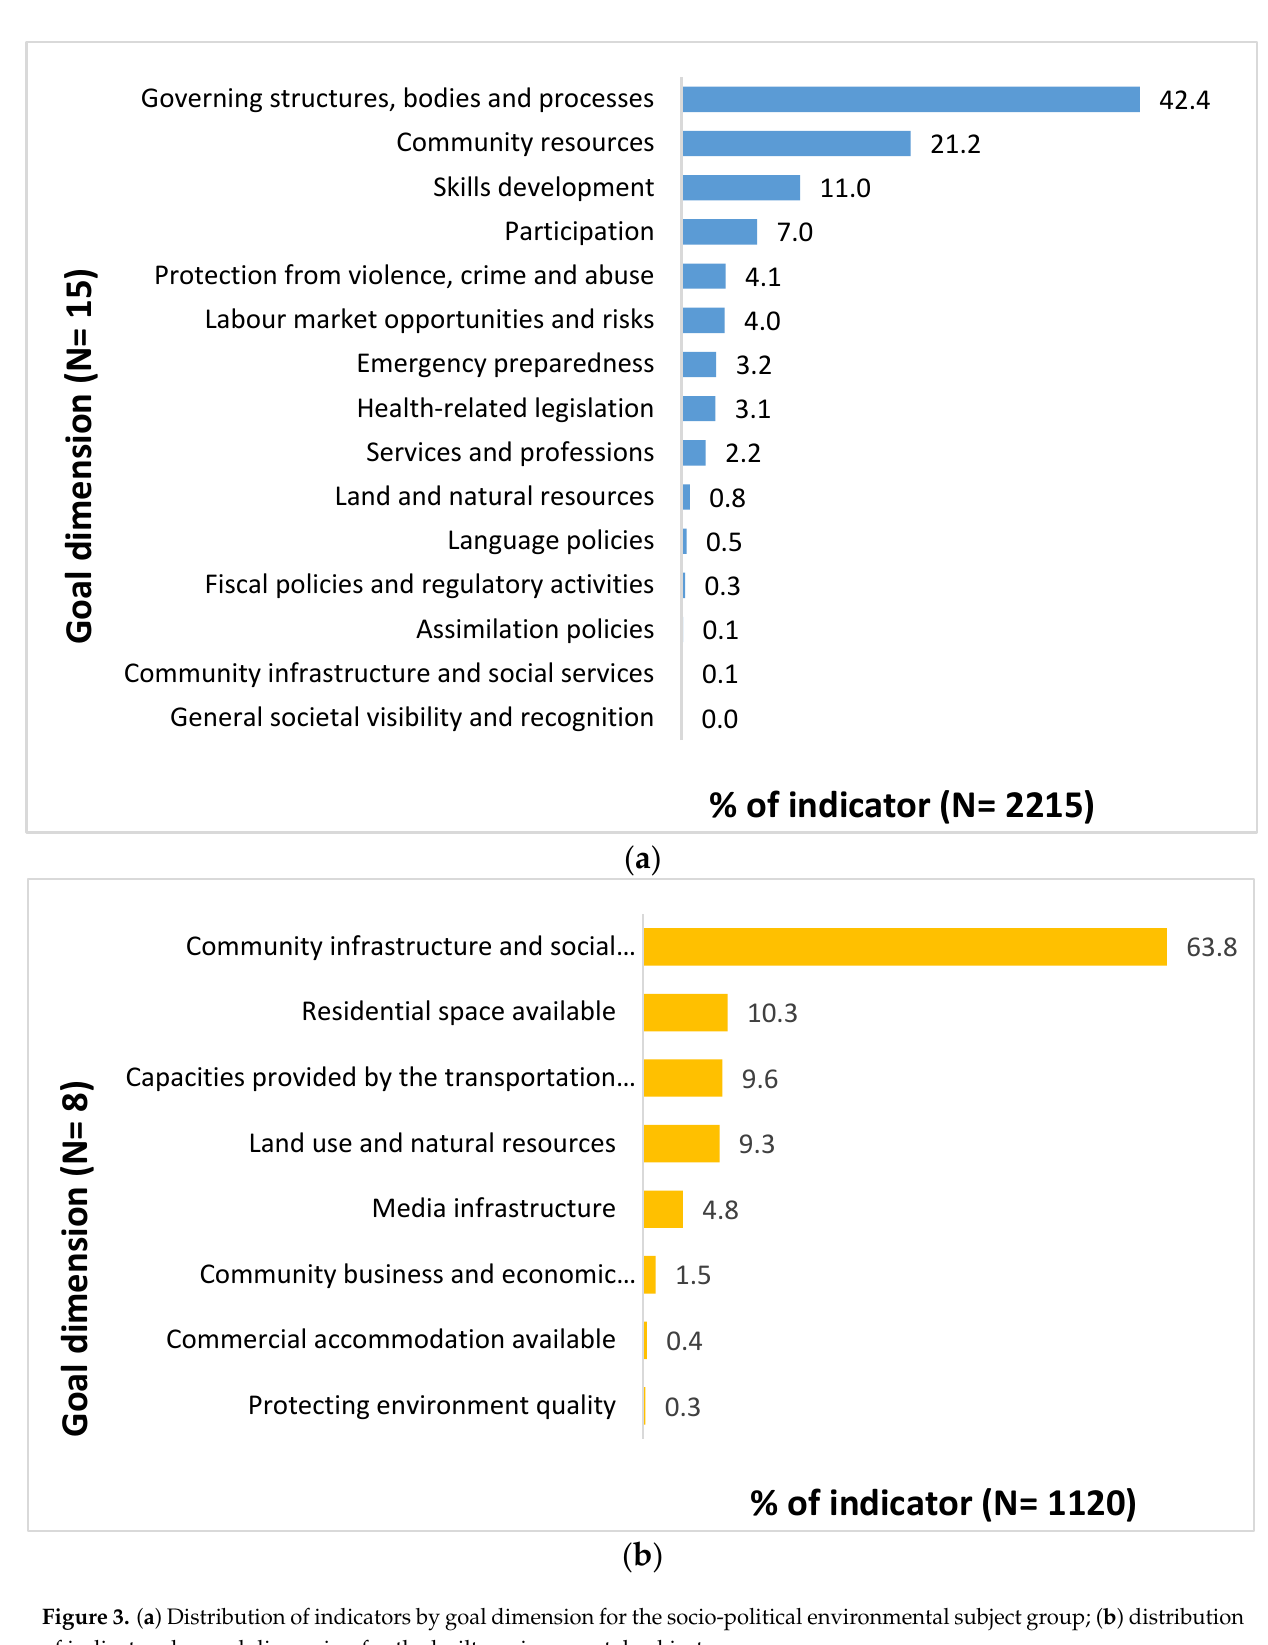
Figure 3. ( a ) Distribution of indicators by goal dimension for the socio-political environmental subject group; ( b ) distribution of indicators by goal dimension for the built environmental subject group.